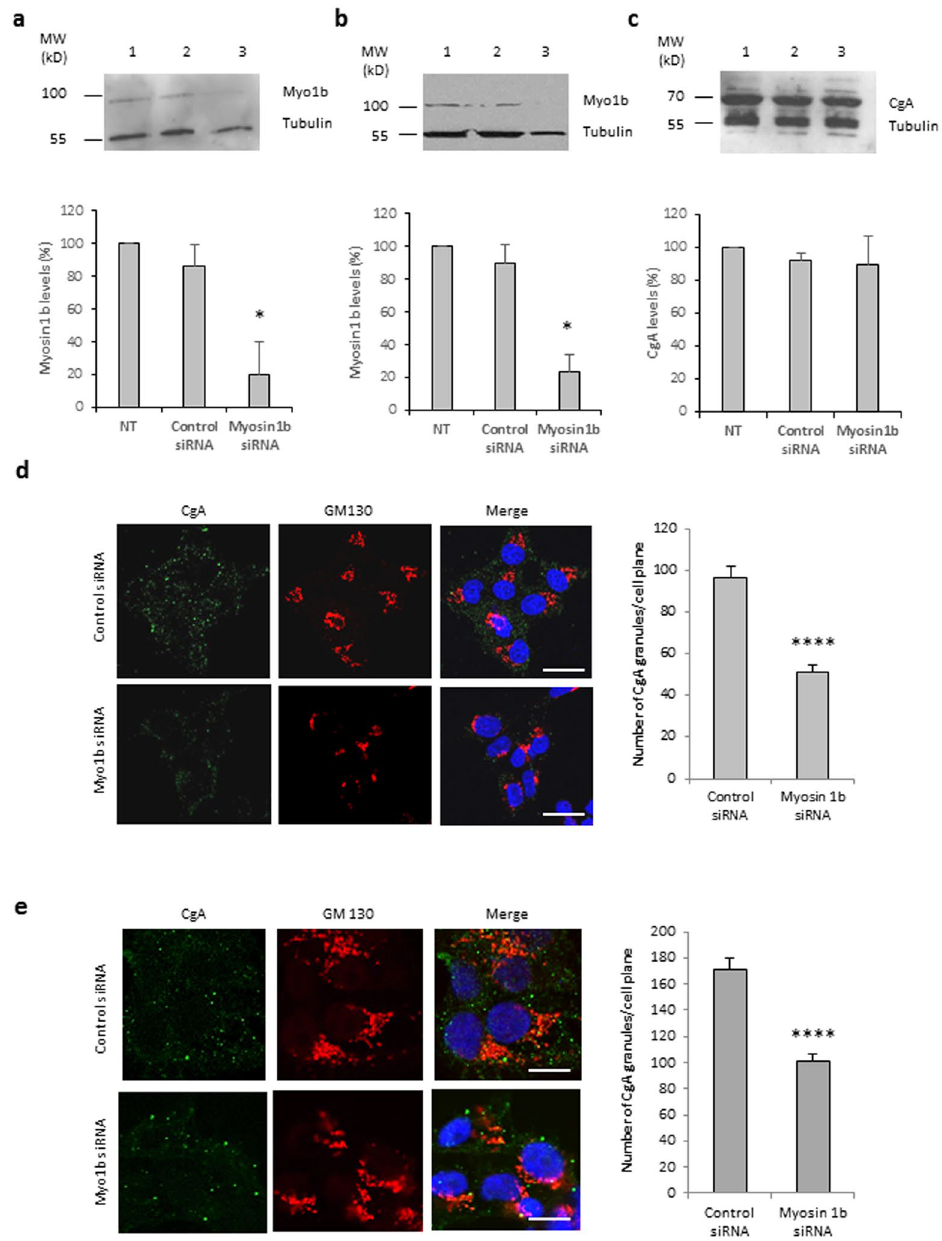
Figure 2. Myosin 1b depletion reduces the biogenesis of CgA-containing granules in PC12 and COS7 cells. ( a – c ) Protein extracts were analyzed by immunoblotting. Cropped blots showing protein expression levels of Myo1b and tubulin in lysates of COS7-CgA cells ( a ) or PC12 cells ( b ), non-transfected (lane 1), transfected with control siRNA (lane 2) or myosin 1b siRNA (lane 3). ( c ) Cropped blots showing protein expression levels of CgA and tubulin in lysates of PC12 cells, non-transfected (lane 1), transfected with control siRNA (lane 2) or myosin 1b siRNA (lane 3). Histograms represent a semi-quantitative analysis of the amount of myosin 1b or CgA found in cells transfected with control siRNA or myosin 1b siRNA from three independent experiments. * P < 0.05 (Mann-Whitney test). (Full-length blots of each tested protein are reported in Supplementary Figure S2). ( d ) PC12 cells were transfected with control siRNA or Myo1b siRNA, fixed, immunolabelled with anti-CgA and GM130 antibodies, and analyzed by confocal microscopy. Representative confocal microscopy sections throughout the cells are shown. The scale bar represents 10 µ m. The number of CgA granules in PC12 cells transfected with control siRNA or Myo1b siRNA was quantified and expressed as mean + s.e.m. from three independent experiments (n = 36 cells). **** P < 0.0001 (Student’s t -test with Welch’s correction). ( e ) COS7- CgA cells were transfected with control siRNA or Myo1b siRNA, fixed, immunolabelled with anti-CgA and GM130 antibodies, and the distribution of CgA was analyzed by confocal microscopy. Representative confocal microscopy sections throughout the cells are shown. The scale bar represents 10 µ m. The number of CgA granules in COS7-CgA cells, transfected with control siRNA or myosin 1b siRNA, was quantified and expressed as mean + s.e.m. from three independent experiments (n = 43 cells). **** P < 0.0001 (Mann-Whitney